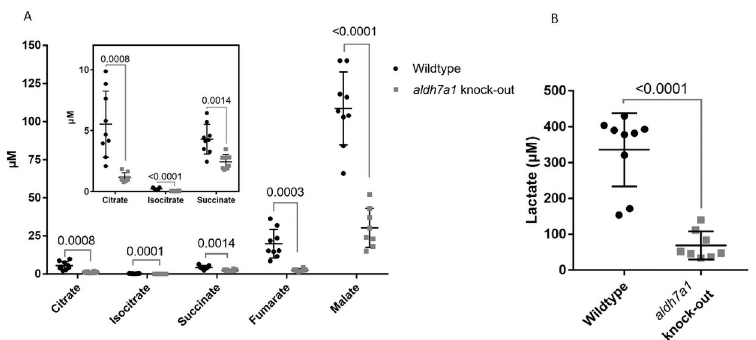
Fig 4. A & B. Scatterplot of quantification of the TCA cycle metabolite levels. TCA cycle metabolite levels are reduced in aldh7a1 knock-out zebrafish embryos. Scatterplot of quantification of the TCA cycle metabolite levels decreased in aldh7a1 11 dpf knock-out embryos (aldh7a1 knock-out, grey squares) relative to the wildtype age- matched controls (Wildtype, black circles), as measured by LC-MS/MS. Each dot represents metabolite data collected from 20 embryos. p values were calculated by unpaired student t-test for multiple measurements followed by Holm- Sadak correction for multiple analysis. Error bars, SD.